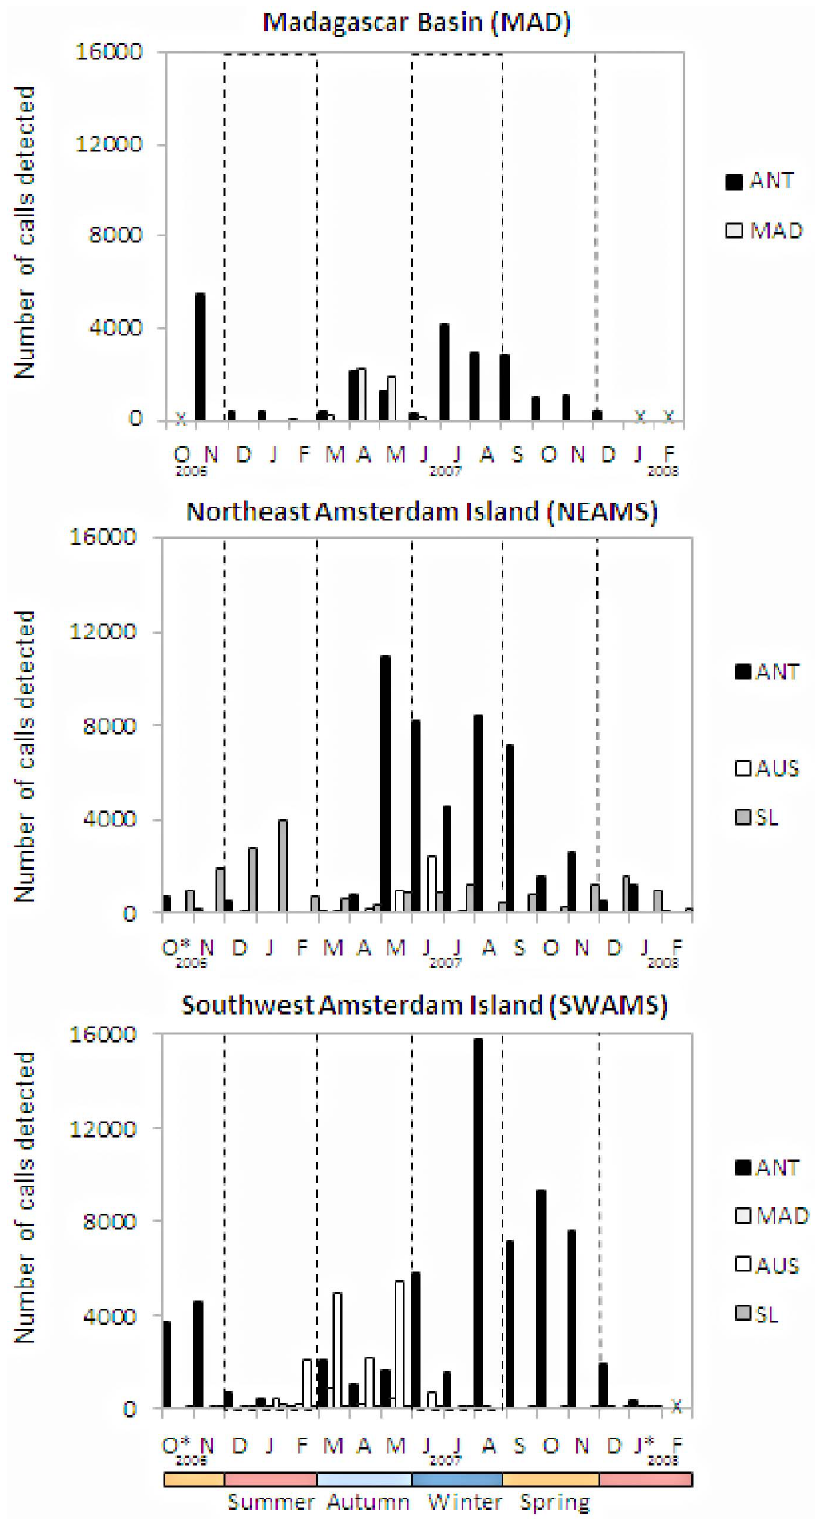
Figure 3. Number of blue whale calls detected at three sites. Antarctic blue whale calls (ANT - black), Madagascar calls (MAD -light grey), Australia calls (AUS - white) and Sri Lanka calls (SL – grey). X indicates no data were available and * indicates data were available only a part of the month.